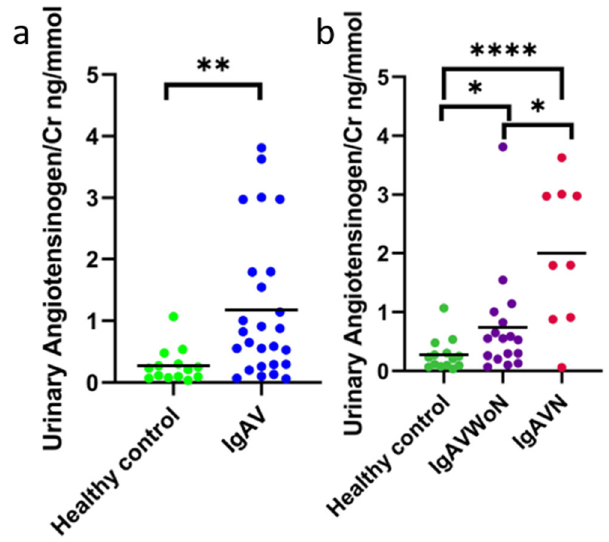
Figure 1. Urinary creatinine normalised angiotensinogen concentration, separated by disease and renal involvement status. The mean concentration for each patient group is denoted. ( a ) Urinary angiotensinogen is significantly elevated in IgAV patients compared to HC. ( b ) When separated by renal involvement, angiotensinogen levels were elevated compared to HC regardless of the presence of renal disease; which was defined as >30 mg/mmol creatinine, with IgAVN having the greatest angiotensinogen concentration. * p < 0.05, ** p < 0.01, **** p < 0.0001.